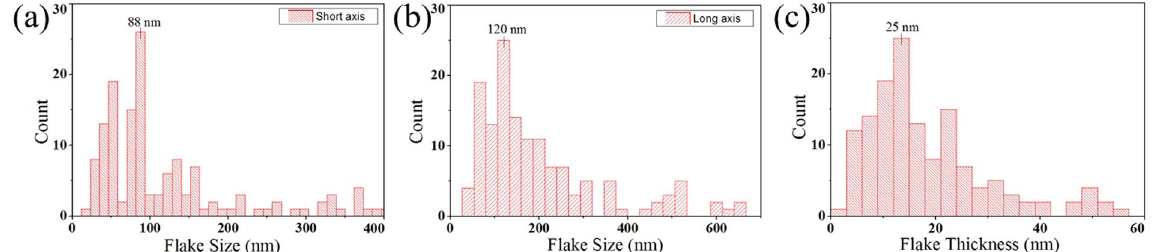
Figure 2. The statistical data of the AFM measurement among 150 PtTe 2 flakes with respect to the lateral dimensions of ( a ) short axis, ( b ) long axis, and ( c ) thickness of the PtTe 2 flakes.